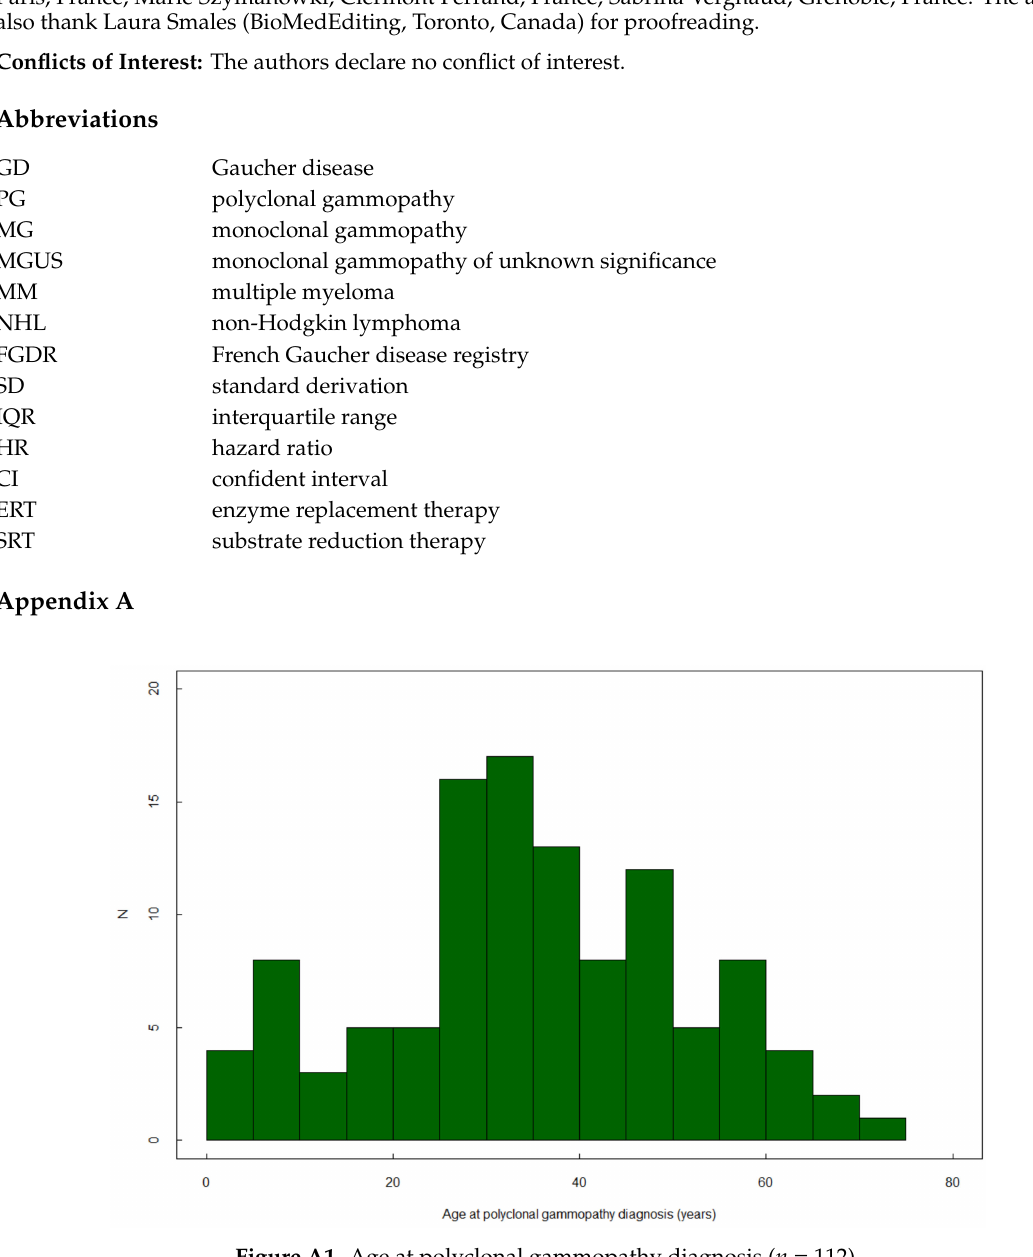
Figure A1. Age at polyclonal gammopathy diagnosis ( n =